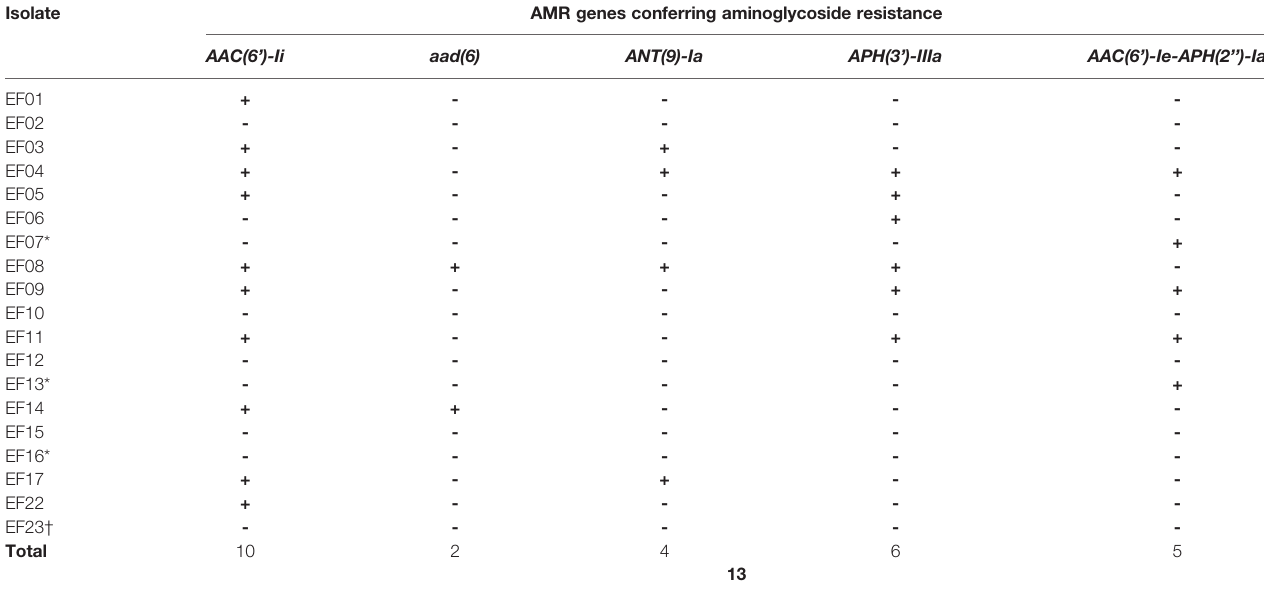
TABLE 3 | Genes detected by short-read next-generation sequencing that confer antimicrobial resistance (AMR) to aminoglycoside. Isolate